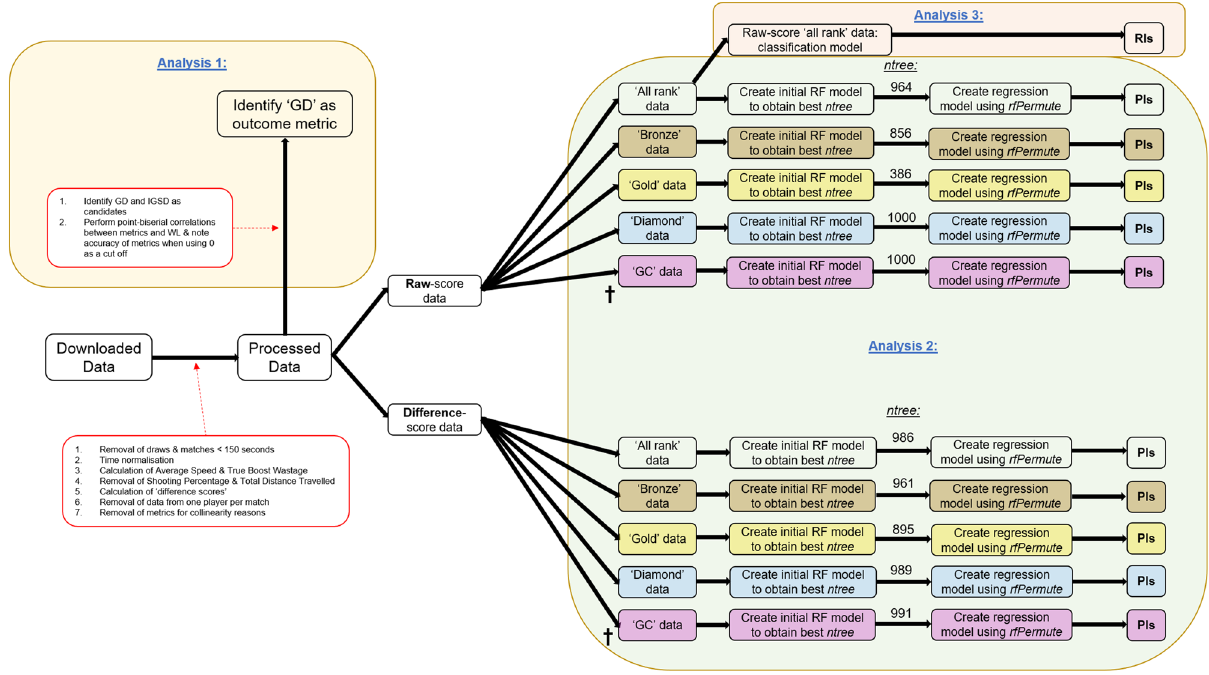
Figure 6. Flowchart depicting the methods of the current study. The three outlined analyses are labelled in blue. The † highlights where average speed was removed due to